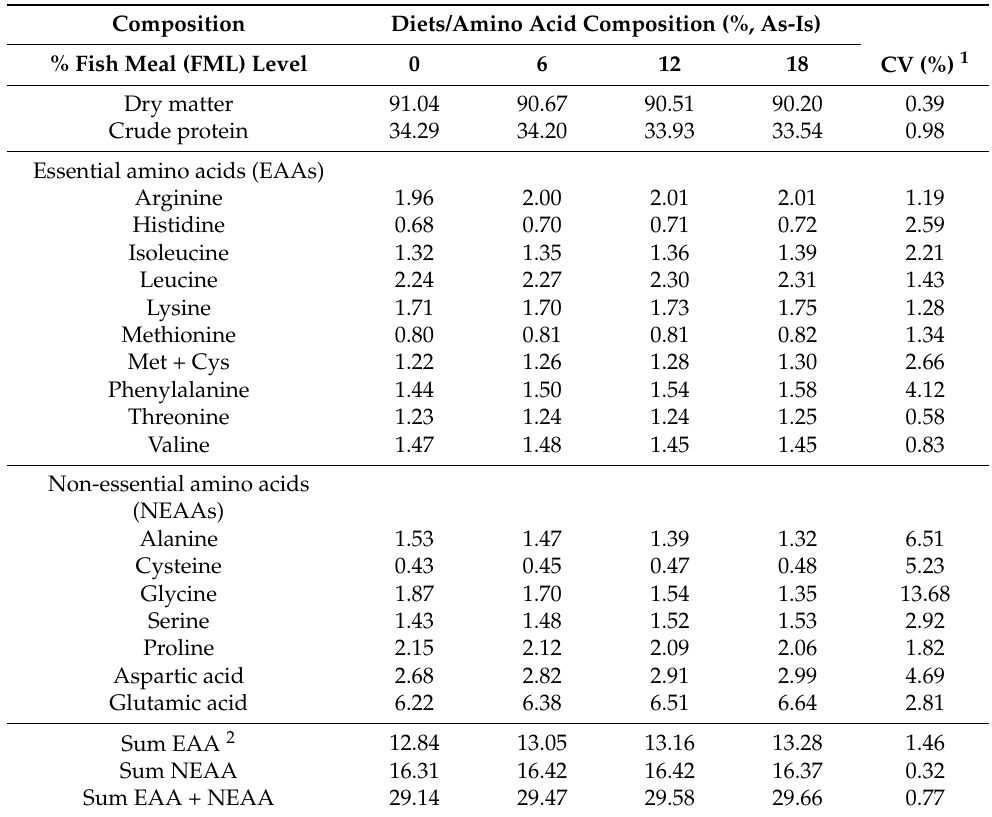
Table 4. Crude protein and amino acid composition (% of the diet, as-is) of experimental diets used in the digestibility